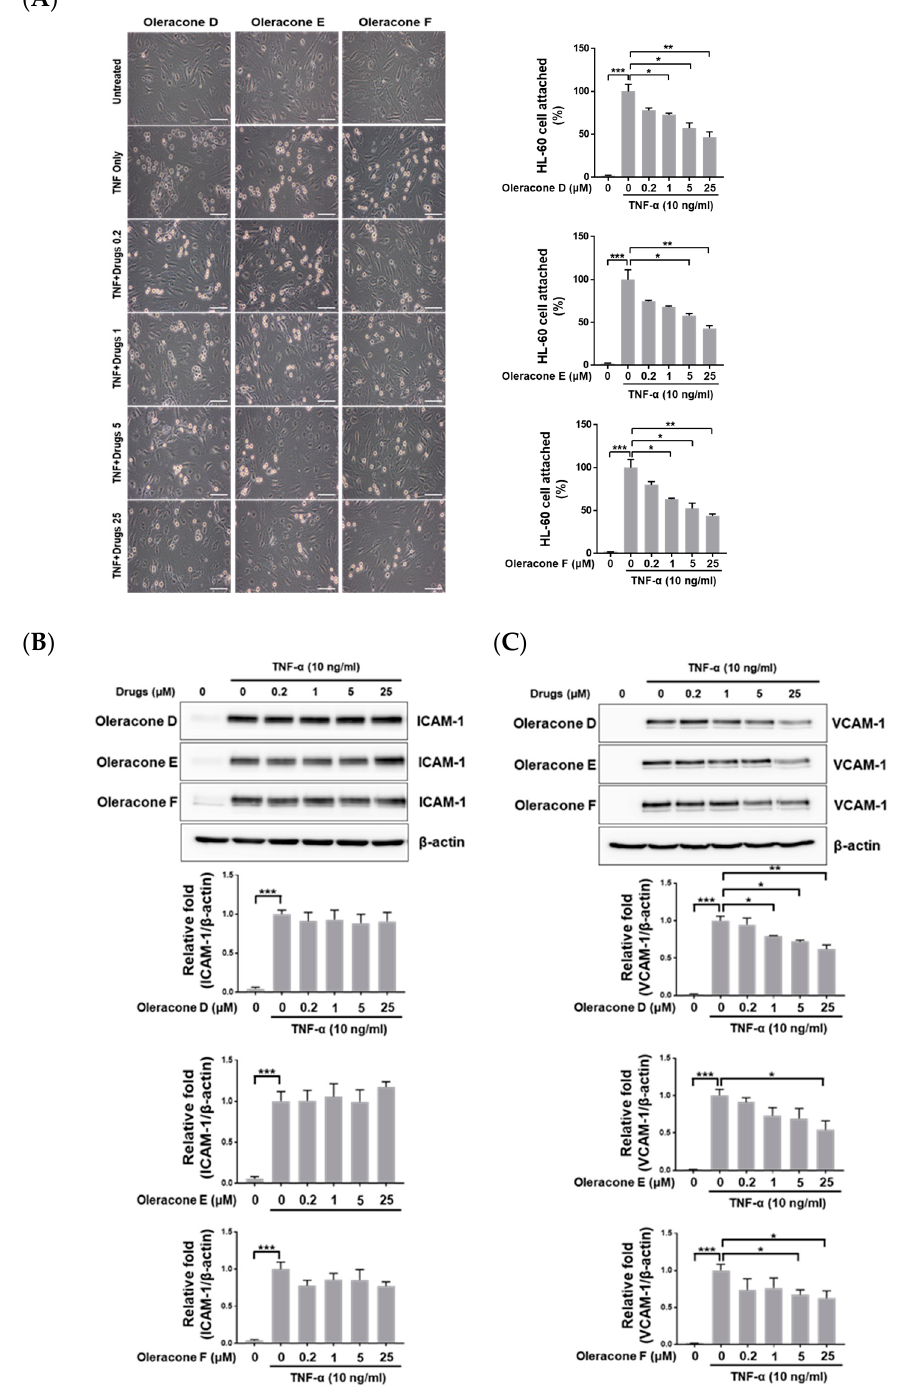
Figure 2. Oleracone F blocked the leukocyte adhesion and the expression of VCAM-1 induced by TNF- α . ( A ) HBMVECs were pretreated with various doses of oleracones 1 h prior to treatment with TNF- α for 8 h and then further incubated with HL-60 cells for 1 h. After non-adherent cells were removed, adherent cells were counted. Scale bar, 100 μ m. ( B , C ) HBMVECs were pretreated with various doses of oleracones 1 h prior to treatment with TNF- α for 8 h. The ICAM-1 ( B ) and VCAM-1 ( C ) protein levels were determined by Western blot analysis using 20 μ g of cell lysates. Quantification was performed using densitometry (ImageJ software, 1.49 v). Results were normalized to β -actin. Data presented are mean ± SEM (n = 3). Statistical difference was determined by Student‘s t -test, and the data are presented as the mean ± SEM, * p < 0.05, ** p < 0.01, *** p < 0.001.